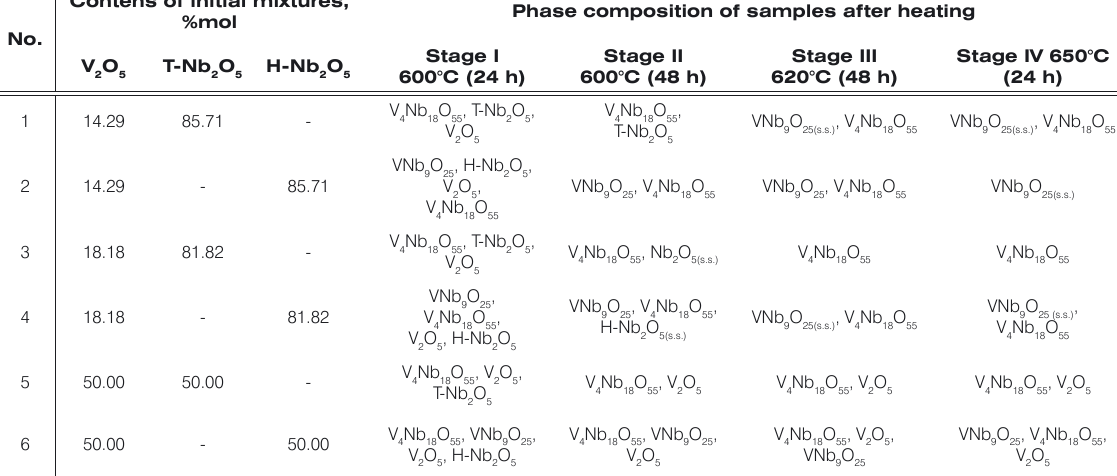
(a) mixture of 18.18 mol% V (b) mixture (a) after heating stage at 600°C (24 h) (c) V Nb O (obtained using mixture (a)) after 4 18 55